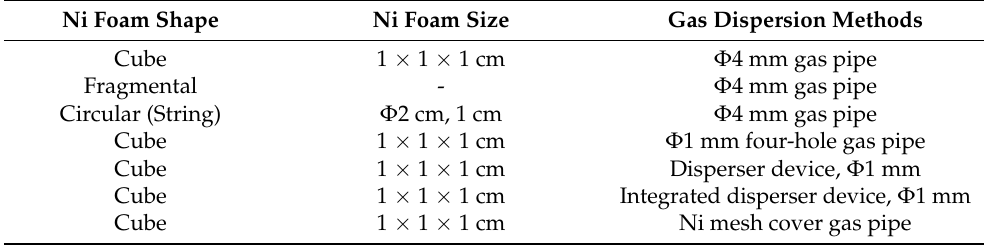
Table 1. Experimental conditions of gas dispersion with different aeration devices [a]